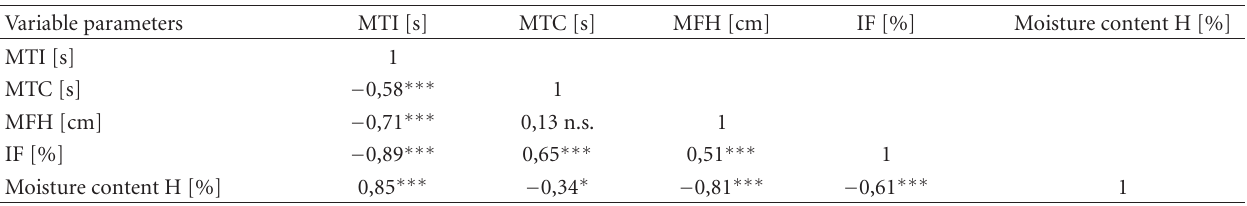
Table 2: Pearson correlation-coe ffi cient matrix of the means of time-to-ignition (MTI), time of combustion (MTC), and flame height (MFH), the ignition frequency (IF) and the moisture content (H) measured on 17 Moroccan tree and shrub species. This correlation analysis was done on 145 observations, and each observation is the mean of 50 flammability tests [22, 24].